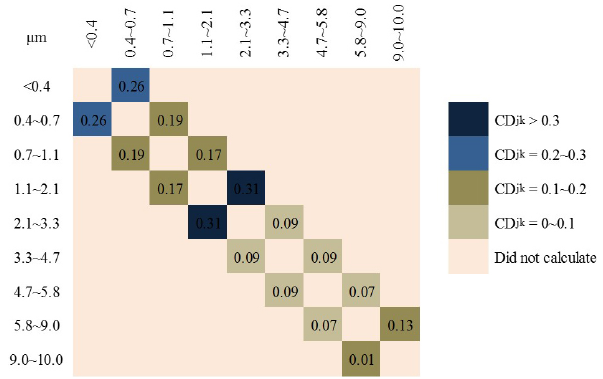
Figure 7. Similarity comparisons of PAHs profiles for the adjacent particles